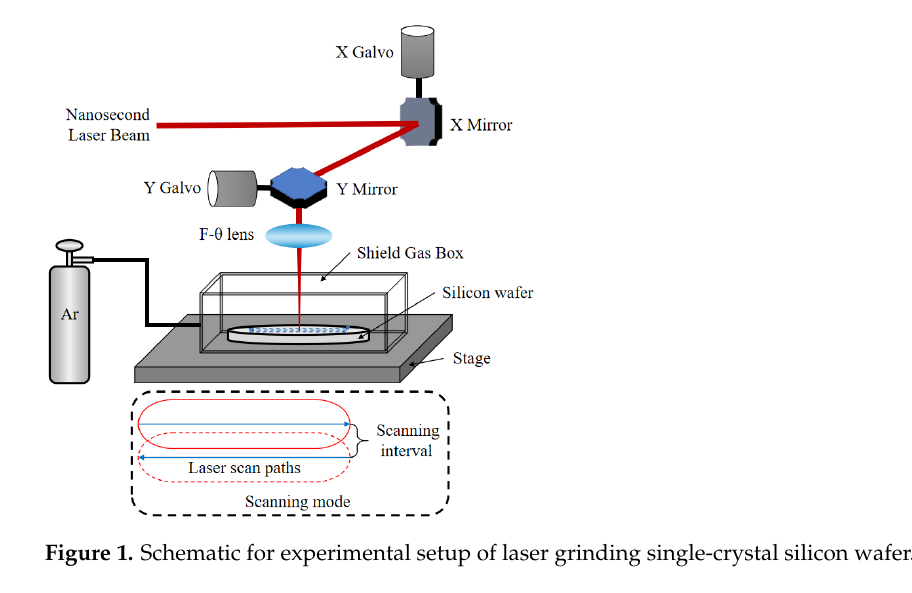
Figure 3. Schematic diagram of laser grinding mechanism: ( a ) laser directly removal of scratches and oxides, ( b ) laser melting, ( c ) temperature field simulation. 3.2. Effect of Laser Grinding on Microstructure Evolution To investigate the microstructure change of single-crystal silicon wafer after laser grinding, the as-received surface and laser-grinded surface were exposed by SEM and EDS. As shown in Figure 4, the EDS face scanning analyses clearly revealed Si, C, and O Silicon wafer PlasmaLaser Beam Surface Oxide Layer & Scratch